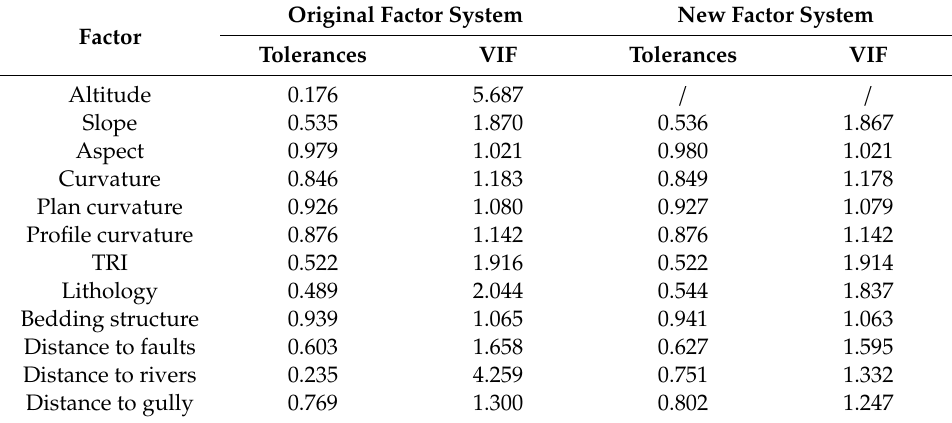
Table 4. Multicollinearity of the causal factors. VIF: variance inflation factors.